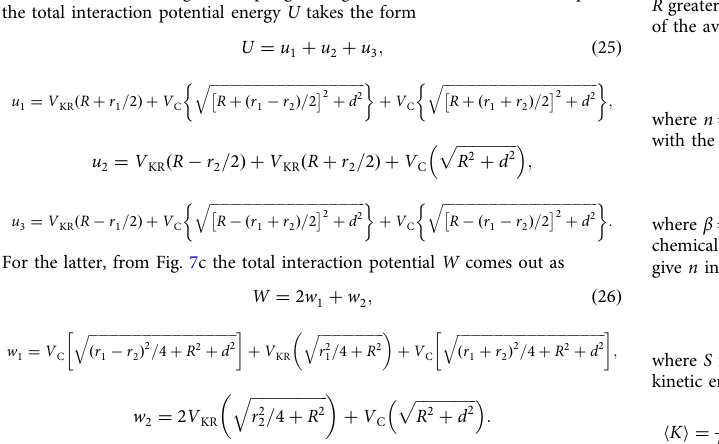
q(cid:3) ffiffiffiffiffiffiffiffiffiffiffiffiffiffiffiffiffiffiffiffi r 2 1 = 4 þ R 2 ffiffiffiffiffiffiffiffiffiffiffiffiffiffiffiffiffiffiffiffi ffiffiffiffiffiffiffiffiffiffiffiffiffiffiffiffi p(cid:14) R 2 þ d 2